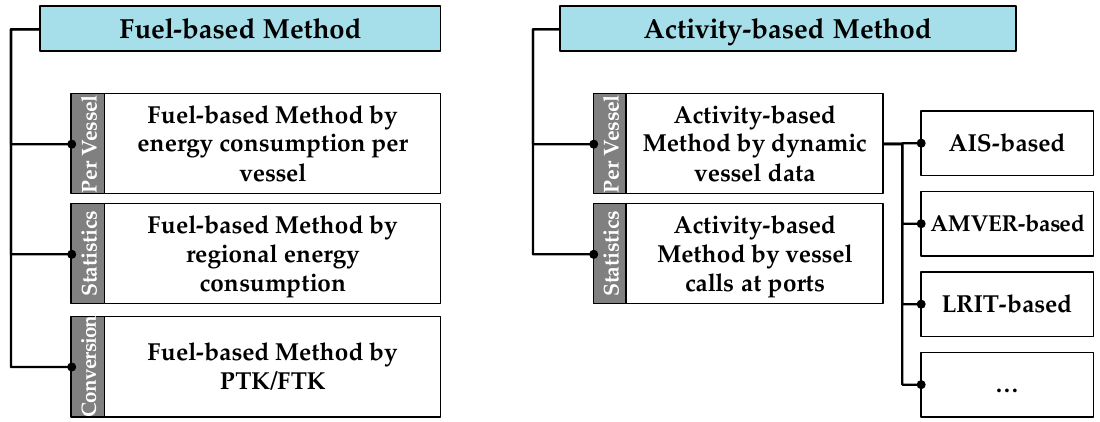
Figure 1. Relations among main inventory compilation methods for ship emissions.